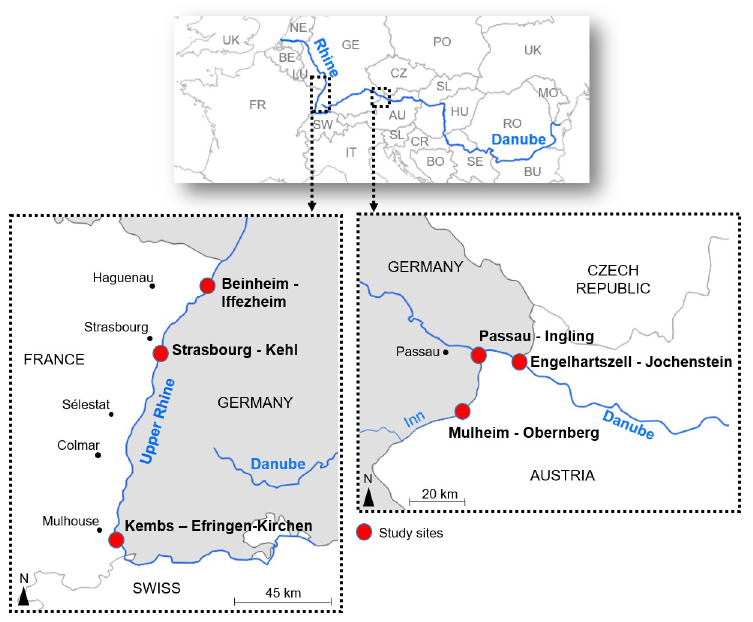
Fig 1. Location of study sites along the Upper Rhine (Kembs-Efringen-Kirchen, Strasbourg-Kehl and Beinheim- Iffezheim) and at the confluence of the Inn (Mulheim-Obernberg and Passau-Ingling) and Danube